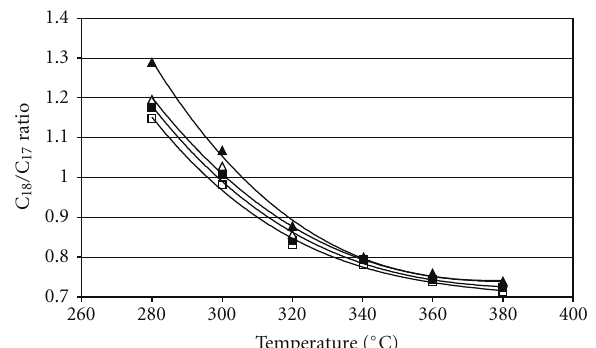
Figure 7: The ratio of C 18 /C 17 para ffi ns as a function of the temperature and the pressure; where: and -80 bar pressure (LHSV = 1.0h − 1 , H 2 /waste lard volume ratio (cid:3) = 600Nm 3 /m 3 ).